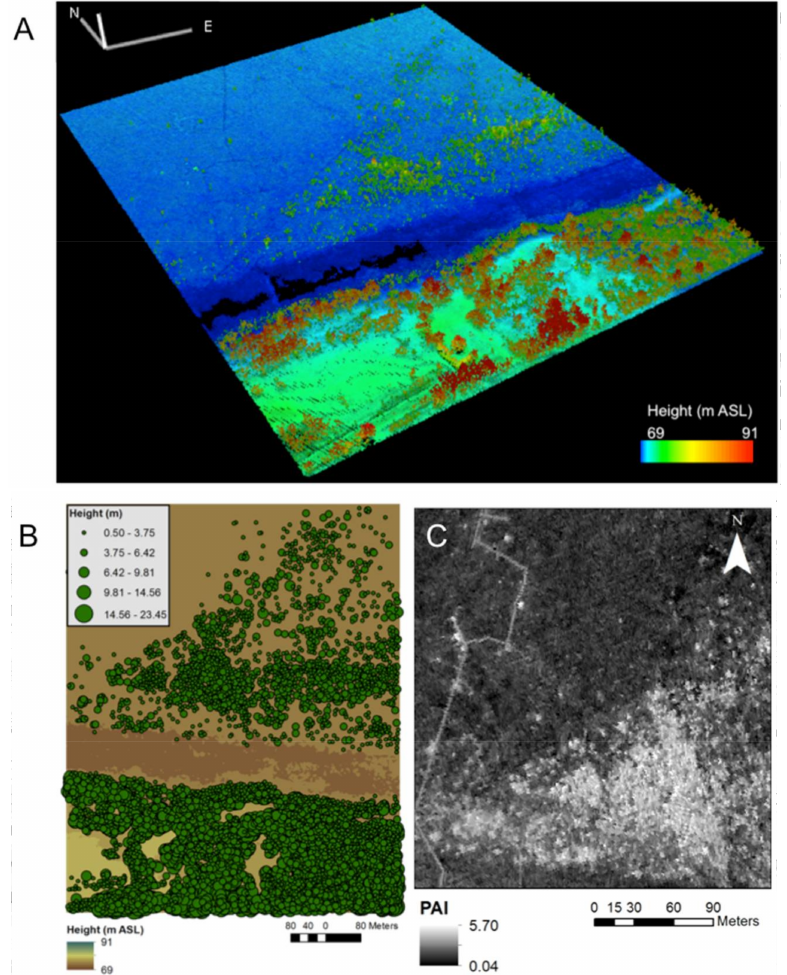
Figure 3. ( A ) Example of the LiDAR point cloud for the research boardwalk area of the Mer Bleue Conservation Area (MBCA); ( B ) digital surface model from the LiDAR (basemap) with points representing trees >30 cm in canopy diameter and height (green points); ( C ) PAI surface derived from the CASI